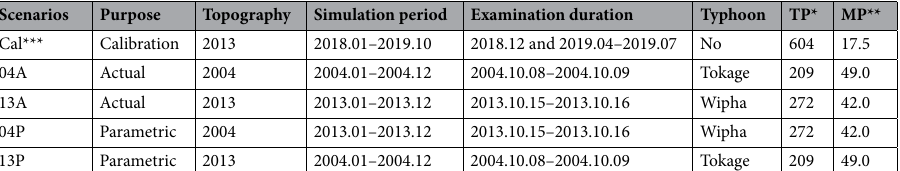
Table 1. The simulated scenarios for calibration, validation, and quantification of the hydrological and hydraulic model. Cal means the simulation for calibration. The numbers in the scenarios column represent the year of input topography, and the letter “A” is for the actual simulations and “P” is for the parametric simulations. *Total precipitation during the examination period (mm). **Hourly maximum precipitation during the examination period (mm). ***There was no typhoon during the examination